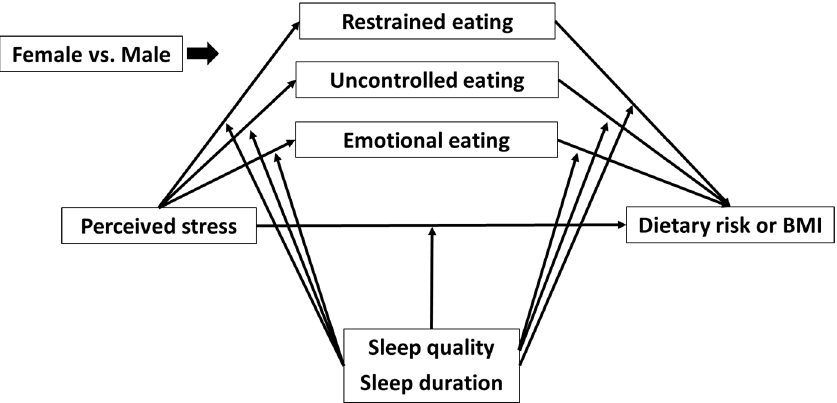
Figure 1. Model 1: The mediation effect of restrained, uncontrolled, and emotional eating on the relationship between perceived stress and dietary risk under the moderation of sleep quality for female students; Model 2: The mediation effect of restrained, uncontrolled, and emotional eating on the relationship between perceived stress and dietary risk under the moderation of sleep quality for male students; Model 3: The mediation effect of restrained, uncontrolled, and emotional eating on the relationship between perceived stress and dietary risk under the moderation of sleep duration for female students; and Model 4: The mediation effect of restrained, uncontrolled, and emotional eating on the relationship between perceived stress and dietary risk under the moderation of sleep duration for male students. Models A to D: same as Models 1 to 4 but BMI was the dependent variable. Note that “others” were excluded from analysis.